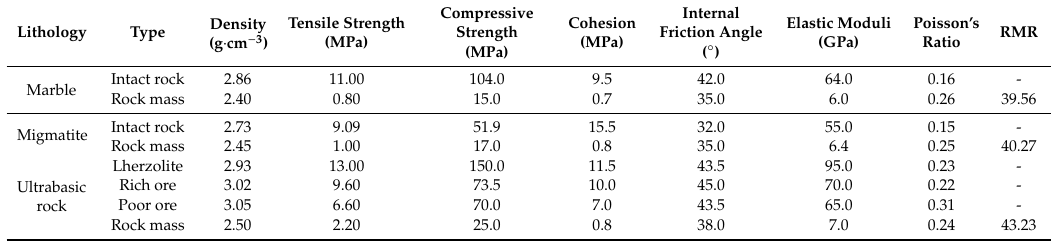
Table 2. Ground stress